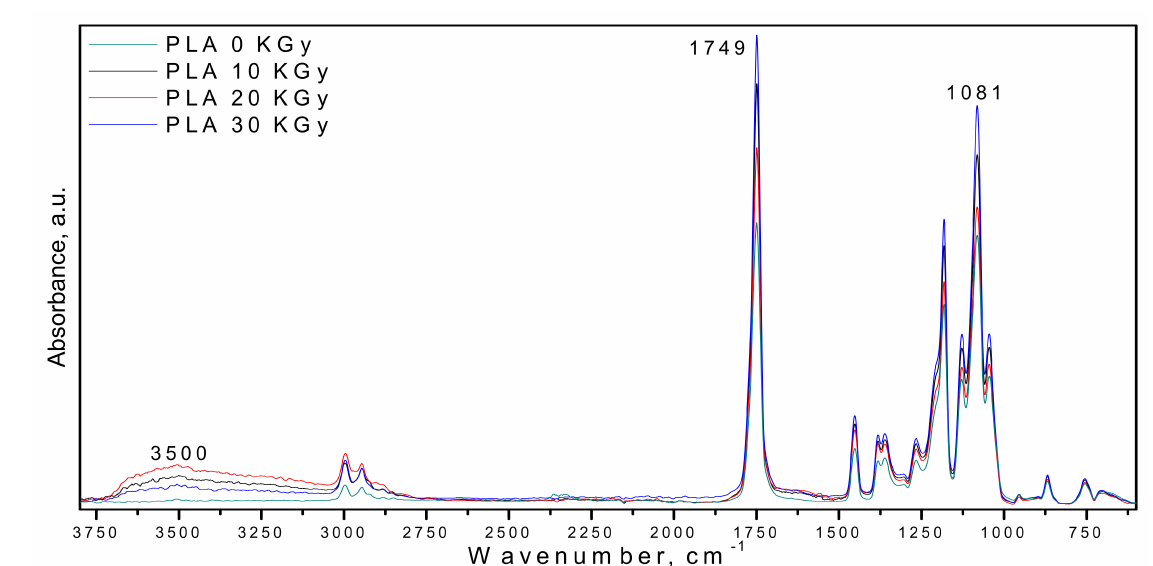
Figure 2. FTIR spectra of PLA at gamma irradiation doses of 0, 10, 20, and 30 kGy. Comparing the spectra of the non-irradiated samples of PLA/R films (PLA/0.25R, PLA/0.5R, and PLA/0.75R) with those γ -irradiated, some significant modifications occur after gamma irradiation, especially in the 1400–800 cm − 1 region—Figure 3. Thus, after sample irradiation, two new absorption bands appear at 1342 and 1238 cm − 1 which are assigned to the CH and CH 2 bending twisting vibrations, respectively. Moreover, in the spectra of non-irradiated samples, the band from 1128 cm − 1 (attributed to the CH 3 rocking or C–O stretching) was shifted to 1100 cm − 1 and changed in a shoulder which is stronger, as evidenced in the case of the samples irradiated at a dose of 30 kGy (blue line). PEG plasticized PLA shows almost the same absorption bands as pristine PLA (not given). The FTIR spectrum of the PEG-plasticized PLA clearly shows the characteristic absorption bands in the regions of 3350–3450 cm − 1 , 2750–3000 cm − 1 , and at 1645 cm − 1 due to O–H bending and stretching vibration, C–H asymmetric stretching vibration, and C=O stretching of ester bonds, respectively. A broad band was observed at 3446 cm − 1 for PEG,